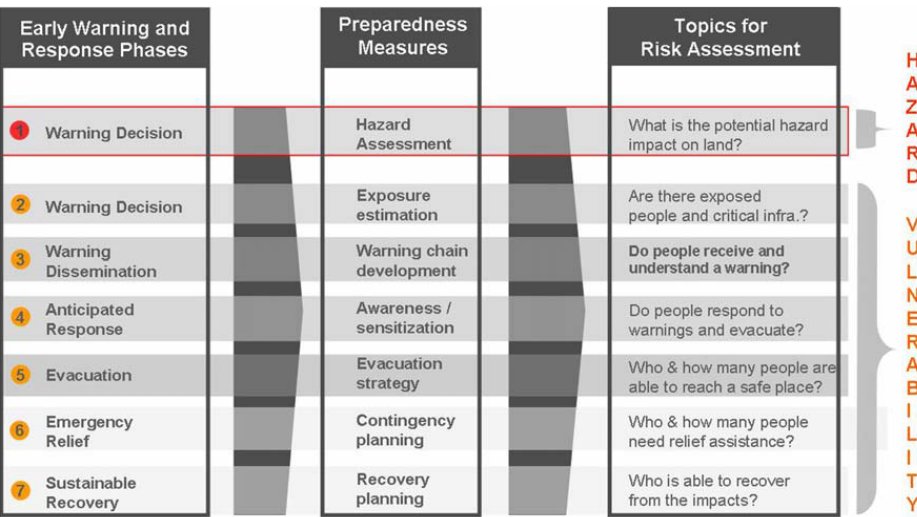
Fig. 2. Tsunami risk assessment framework for people-centred early